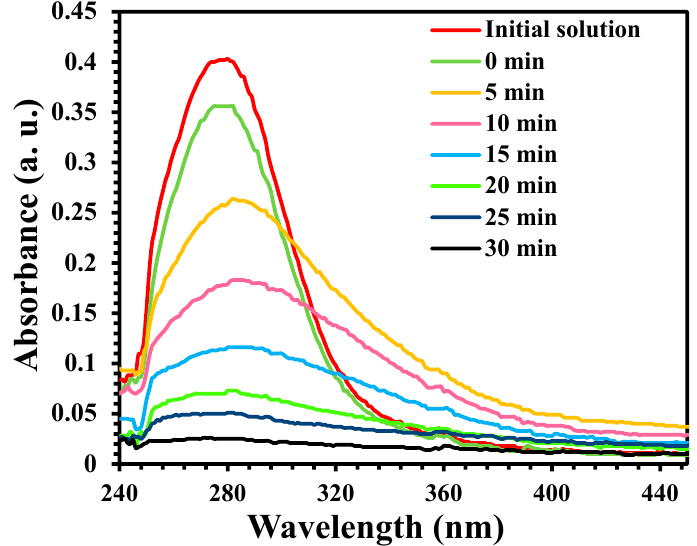
Figure 16. Evolution of the UV-Vis absorbance spectrum of parathion-methyl (PM = 10 mg L − 1 ).